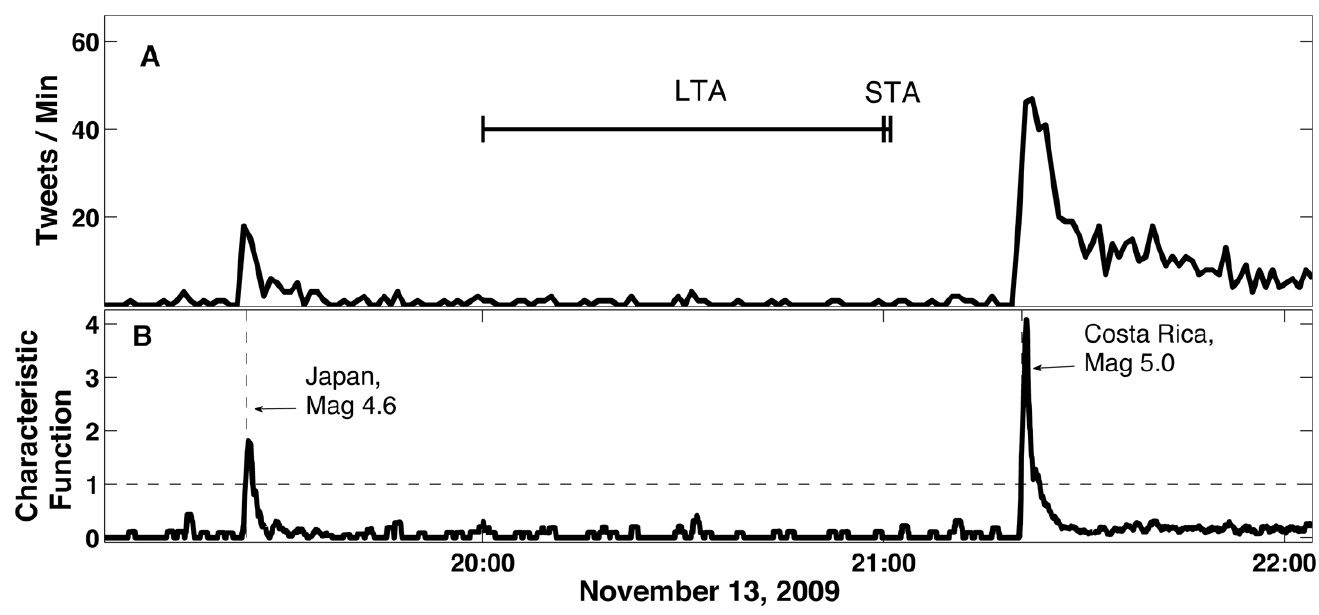
Figure 1. Illustration of the detection process (see text for details). A) Tweet-frequency or tweetgram for about three hours of tweets on November 13, 2009, in UTC. B) The characteristic function generated from the tweetgram in (A). The characteristic function has a one minute STA, a sixty minute LTA, m = 4, and b =